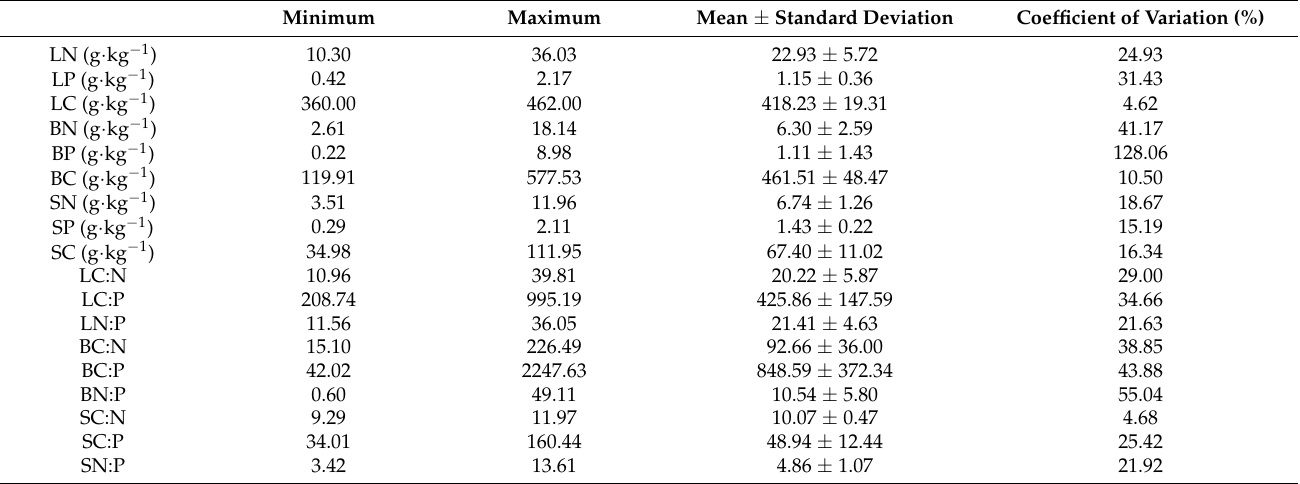
Table 1. Contents and stoichiometric ratios of C, N, and P in leaf, branch, and soil. Statistics of leaf and branch stoichiometric traits of the studied karst primary forest species. LC, leaf